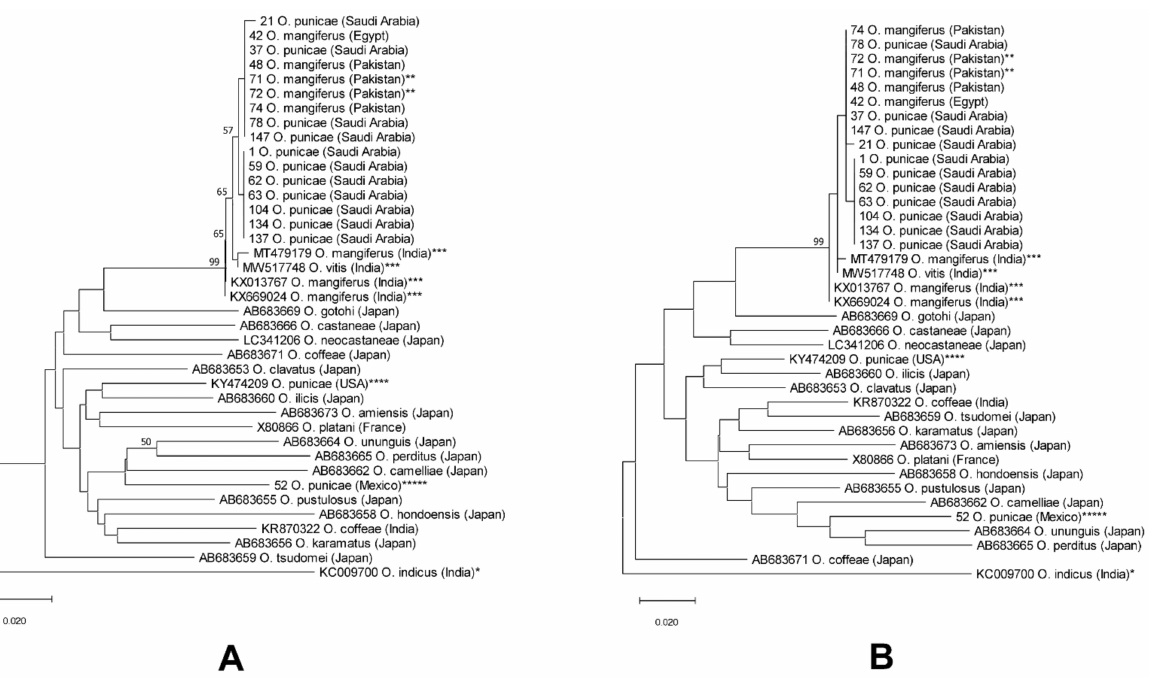
Figure 7. NJ ( A ) and ML ( B ) phylogenetic trees based on COI sequences of 39 spider mite samples, representing different populations of 18 closely related Oligonychus species. A total of 11 sequences were obtained from different hosts and regions in Saudi Arabia, one from Egypt, one from Mex- ico (***** claimed as O. punicae in Mexico), and four from Pakistan ( ** including two samples of O. mangiferus collected from the exact locality whence the original type was previously collected and described for the first time) [9]. Whereas 21 COI sequences of various closely related Oligonychus species were analyzed (including *** three sequences of O. mangiferus and one sequence of O. vitis from India; **** one sequence of the claimed Californian O. punicae ), and one sequence of O. indicus (* an Oligonychus species from the other subgenus Reckiella Tuttle and baker, was used as an outgroup taxon). Numbers on tree branches are bootstrap values obtained from 1000